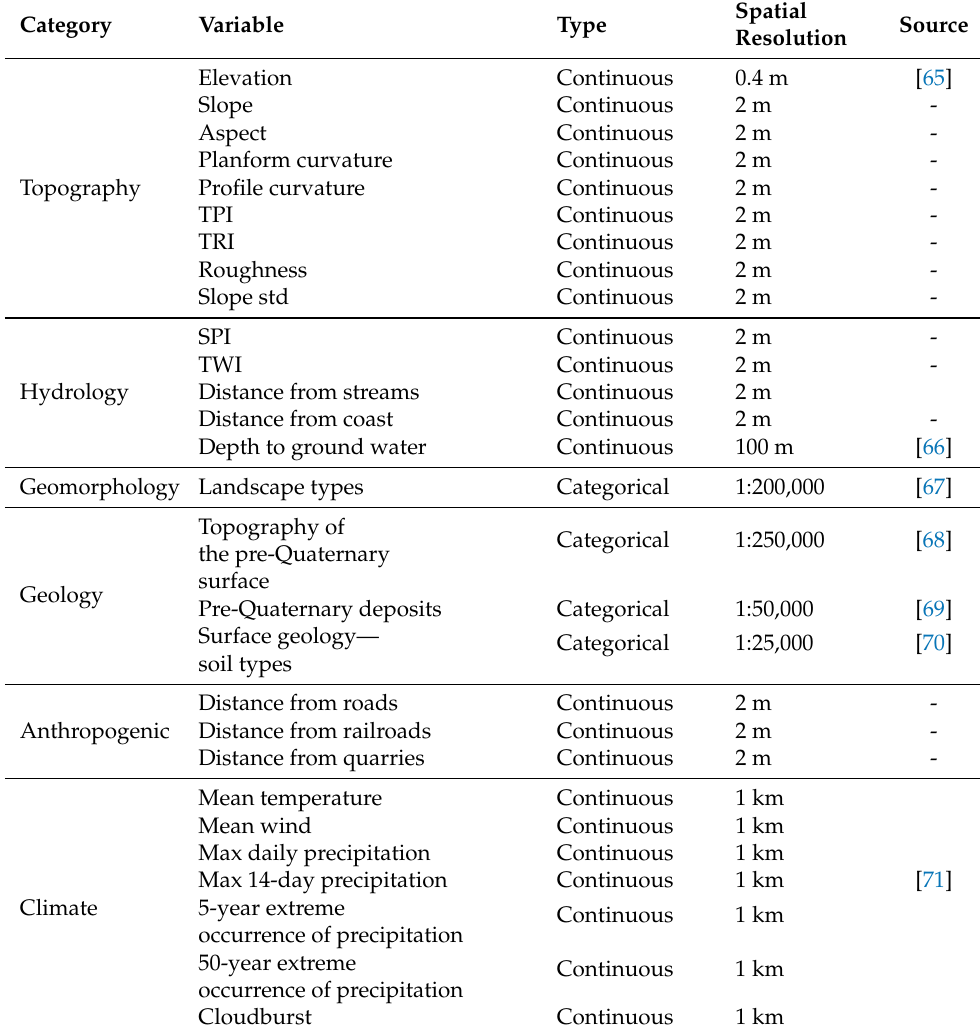
Table 1. Overview of the predictive